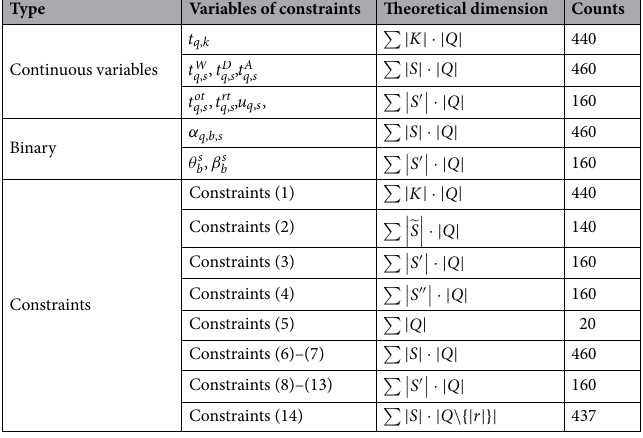
Table 7. Problem complexity.